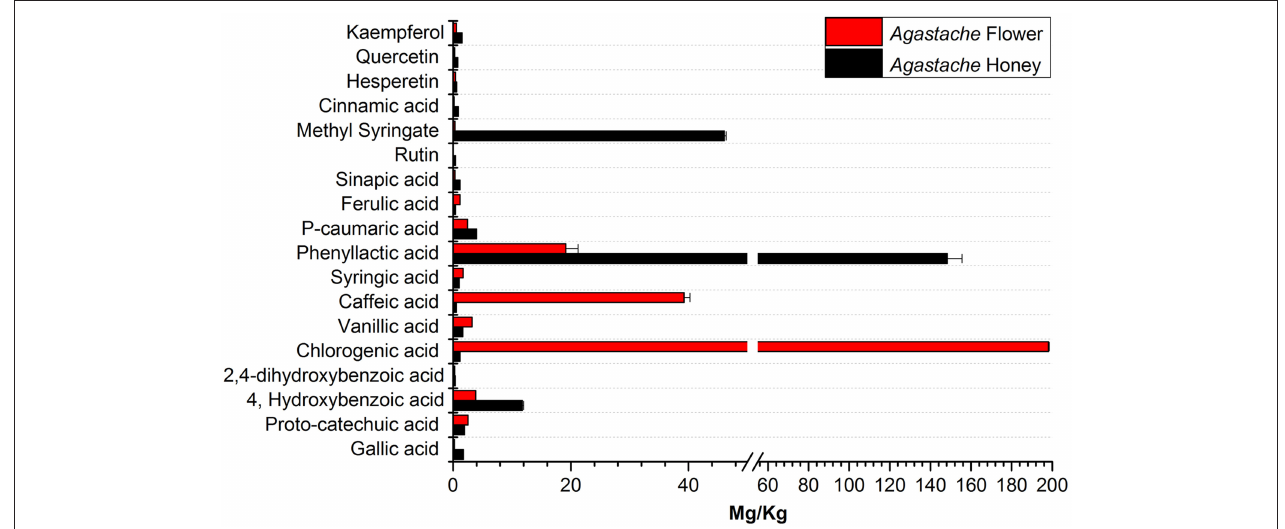
FIGURE 5 | Comparative analysis of phenolic compounds in Agastache honey and Agastache flower.